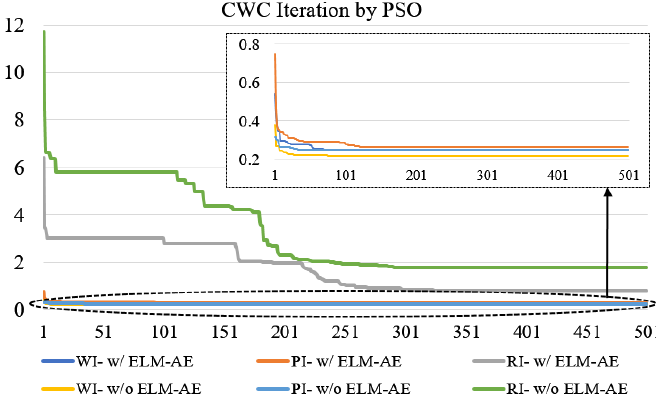
Figure 7. CWC of the best solution in training process for PSO.